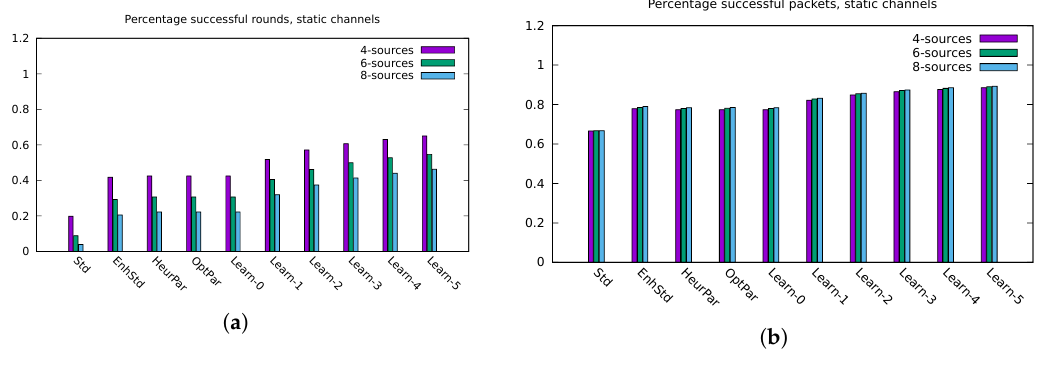
Figure 3. Average fractions of successful rounds and successful packets for all non-relaying schemes and learning (PAR). ( a ) success probability/fraction of successful rounds; ( b ) fraction of successful